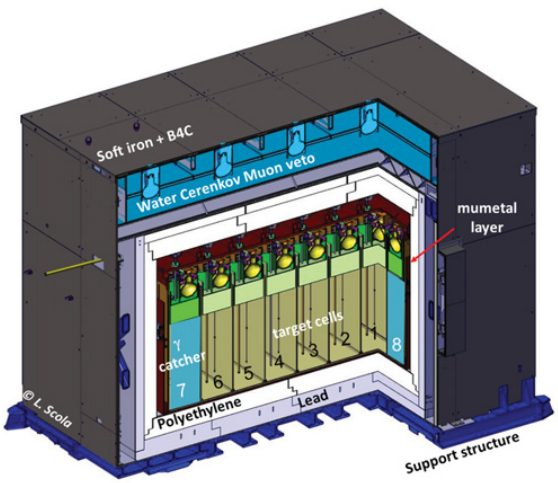
Figure 1. STEREO setup showing the target cells (1 − 6), two of the gamma catcher cells (7 & 8) and the